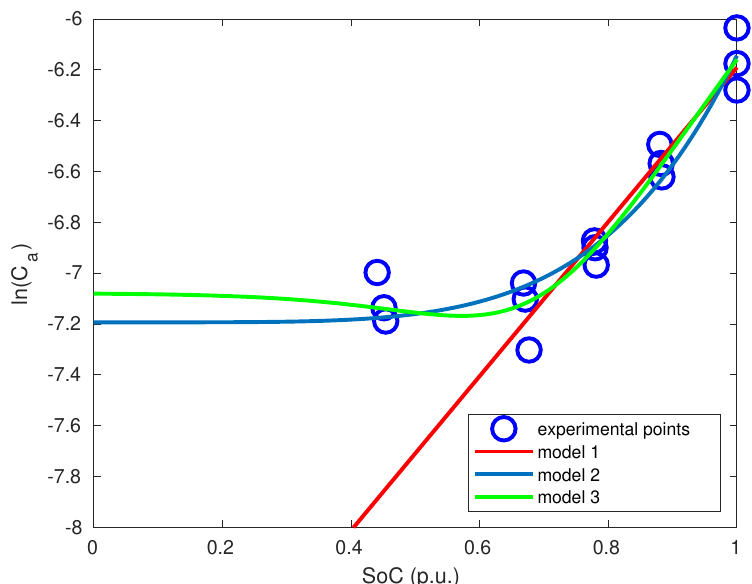
Figure 3. Calendar ageing modelling results: natural logarithm of acceleration coefficient ( C a ) versus SoC . The blue circles are the experimental points, the lines are the result of model 1, 2 and 3 (Equations (9), (10) and (11) respectively). For model 2: z = 5. For model 3: a = 0.7, b = 10. Table 1. Calendar ageing model results: absolute mean errors and maximum errors of C a for different stress formulations. abs. Mean Error Identified Fixed C a /Max. Error (%) Parameters